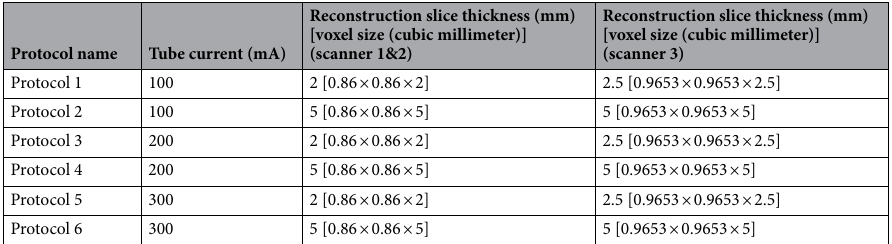
Table 2. Overview of the scanning protocols used to acquire images with the IQ phantom. Six scanning protocols, with same tube voltage (120 kV), pitch (Scanner 1&2: 0.46; Scanner 3: 2.5), and reconstruction kernel, but different tube currents and slice thicknesses were investigated. The phantom was scanned twice on scanners 1–2–3 without repositioning in a 30-min test–retest scenario. The total number of scans acquired with the IQ phantom is 6 protocols × 3 scanners × 2 (test–retest) = 36